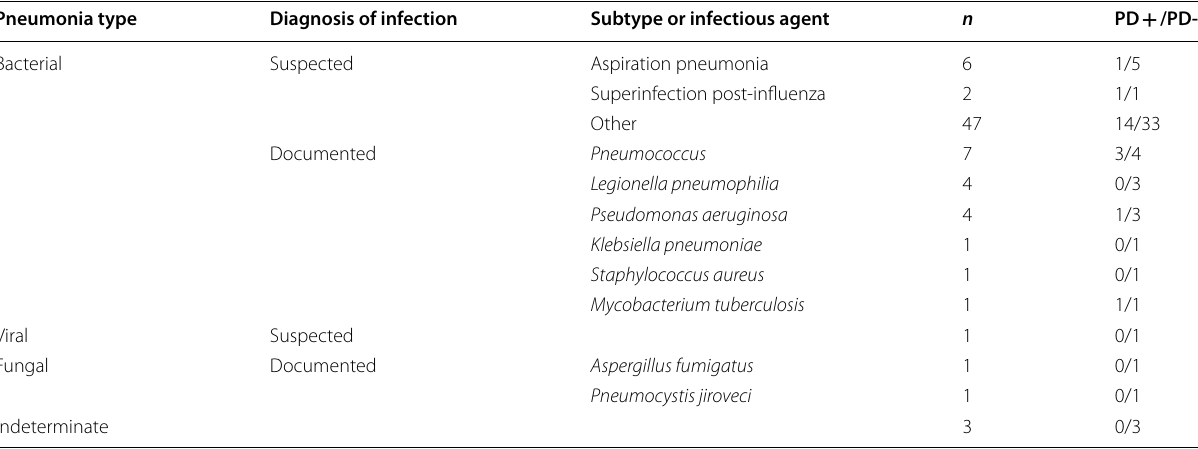
When microbiologically documented, the infectious agent implicated was noted PD : patients with perfusion defects; PD-: patients without perfusion defects +